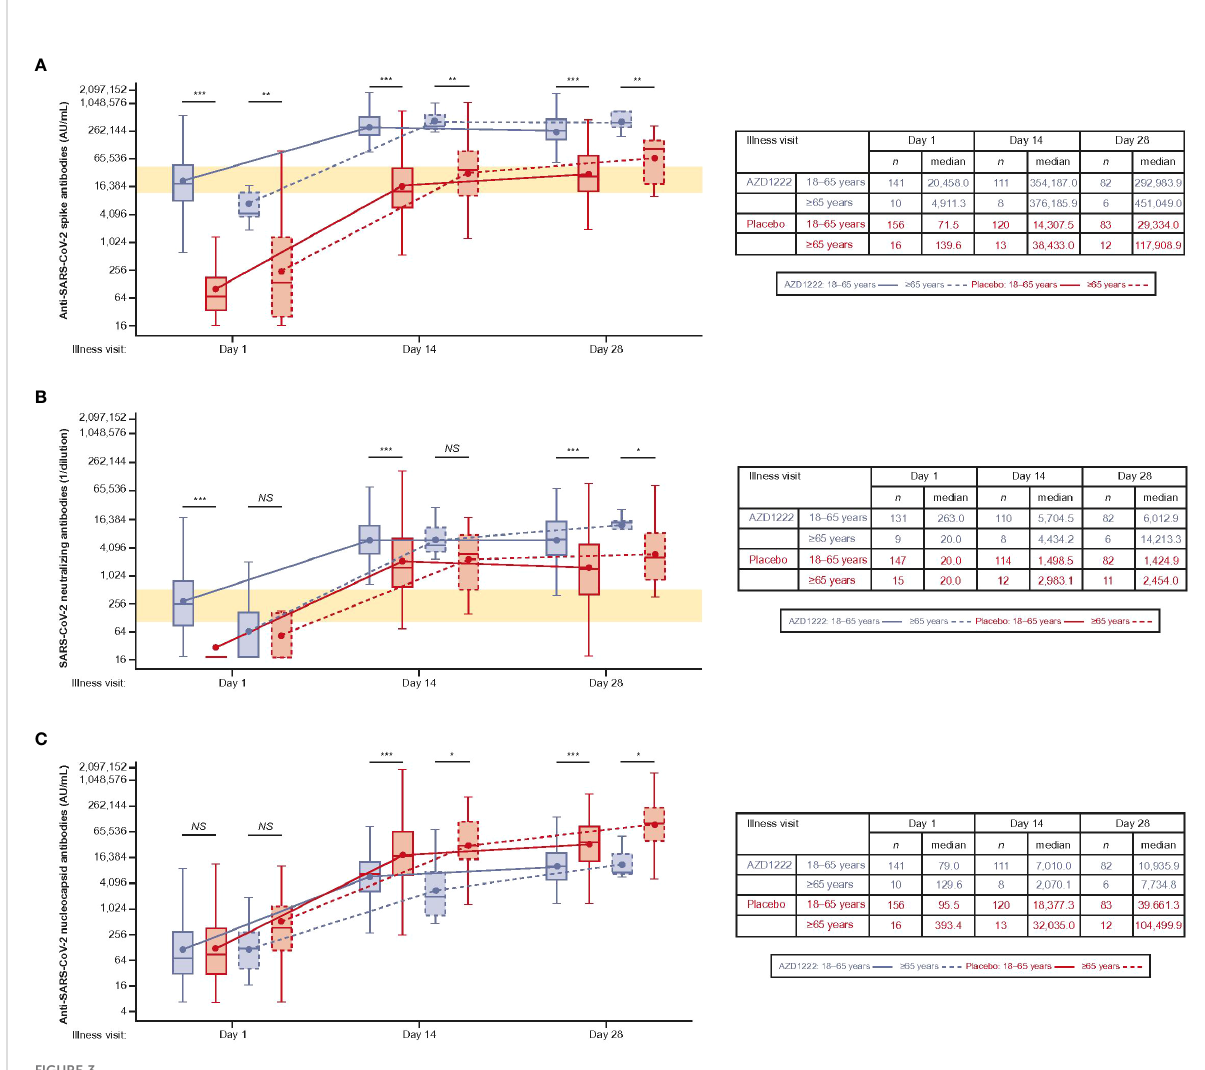
FIGURE 3 The kinetics and magnitude of the breakthrough anti-SARS-CoV-2 antibody response are impacted by age and vaccination status. Levels of anti-SARS-CoV-2 (A) spike-binding, (B) neutralizing, and (C) nucleocapsid antibodies in AU/mL. The bottom and top edges of the box indicate the fi rst and third quartiles, the difference is the IQR, the line inside the box is the median, and the marker inside the box is the geometric mean. The whiskers that extend from the box indicate the minimum and maximum after removing outliers (i.e., datapoints >1.5 x IQR from the box). (A, B) Yellow shaded region denotes peak antibody titers observed during primary analysis [13].Statistical evidence between groups was determined by post-hoc two-tailed Mann-Whitney tests. Not signi fi cant (NS), p>0.05; *p ≤ 0.05; **p ≤ 0.01; ***p ≤